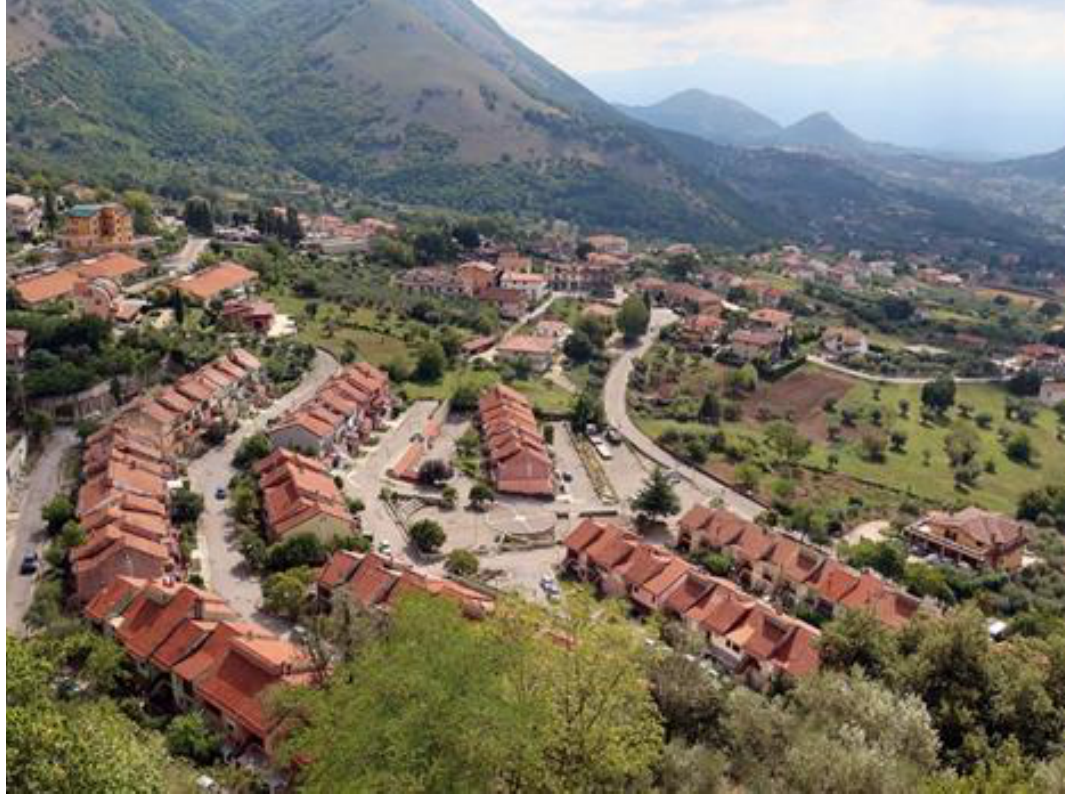
Figure 85. Colliano: new residential settlement known as “Piano di zona” (photos by [35,36]).